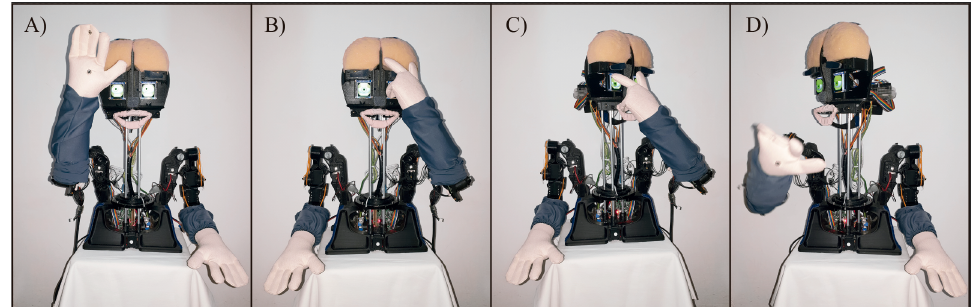
Figure 12. CASTOR robot functionalities for potential use in therapy scenarios. ( A ) illustrates the greeting. ( B ) shows the robot pointing to the head. In ( C ), the robot points to the eyes, and ( D ) shows the robot